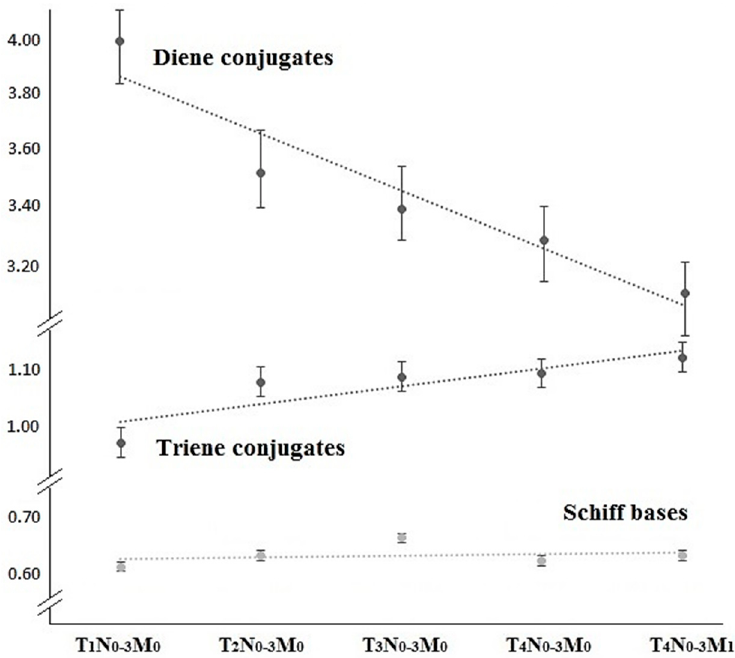
Figure 3. State of lipid peroxidation processes depending on the disease stage.